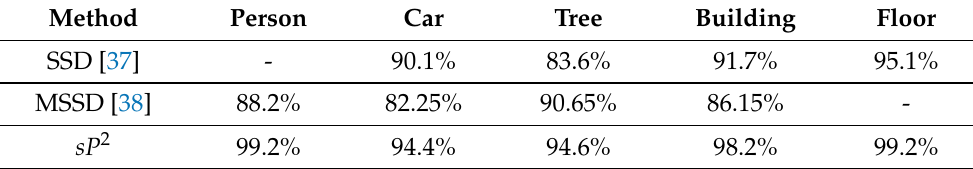
Table 1. Classification accuracy of previous studies using the KNU